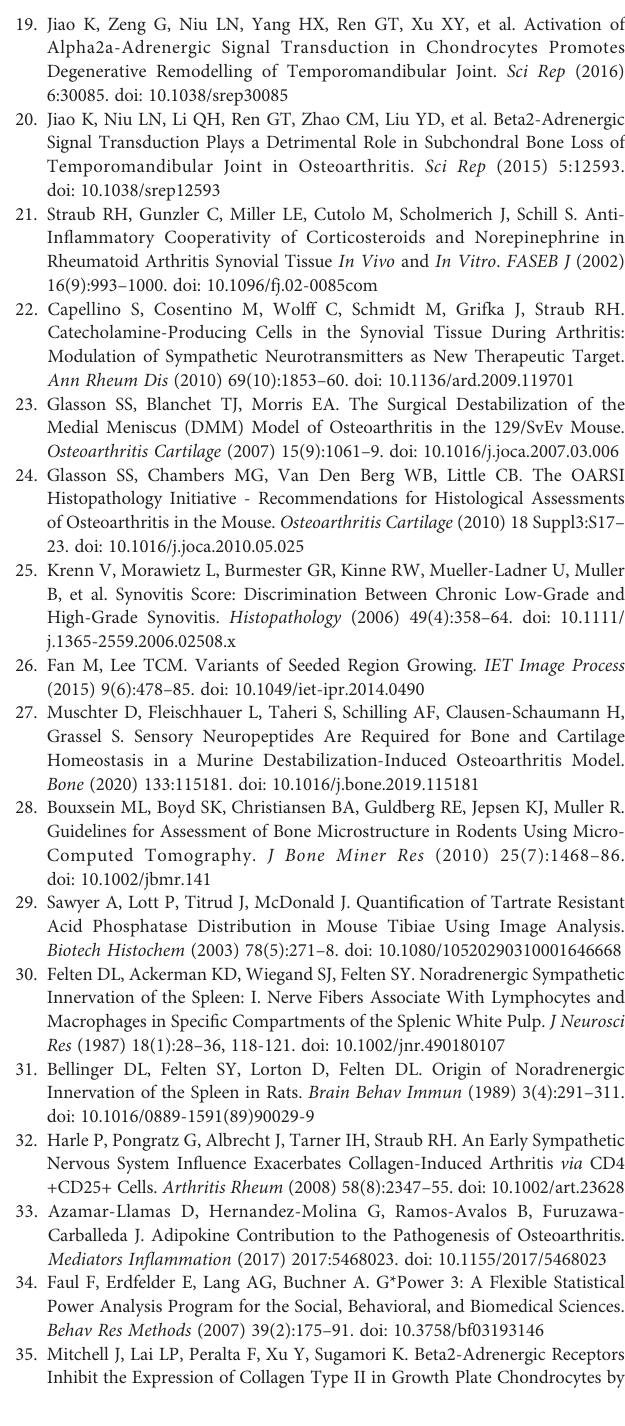
Shamsurgery inWTand Adrb2 -/- DMMmice. (A) Bodyweightdataarerepresented as means +/- SEM (n=5 per group). Signi fi cant p-values are presented as ***p ≤ 0.001, when WT DMM compared to Adrb2 -/- DMM. (B) Body length data are represented as means +/- SEM (n=5 per group). (C) Concentration of absolute splenic NE data are represented as means +/- SEM (n=3 per group). Signi fi cant p- valuesarepresentedas**p ≤ 0.01,whenWTDMMcomparedto Adrb2 -/- DMM. (D) Representative images displaying the abdomen of 6 months old unchallenged WT and Adrb2 -/- mice (H - hearth, L - liver, AF – abdominal